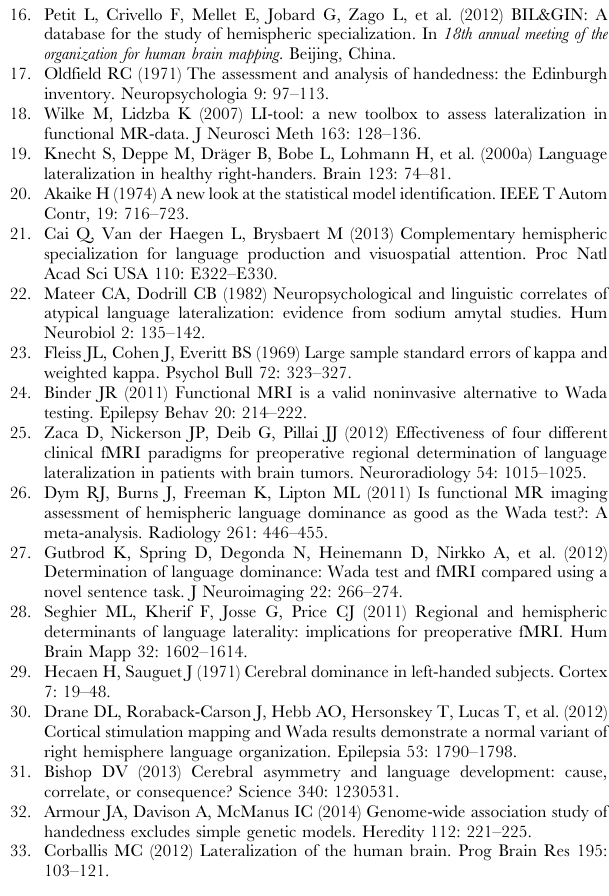
Table S1 Raw data of the study